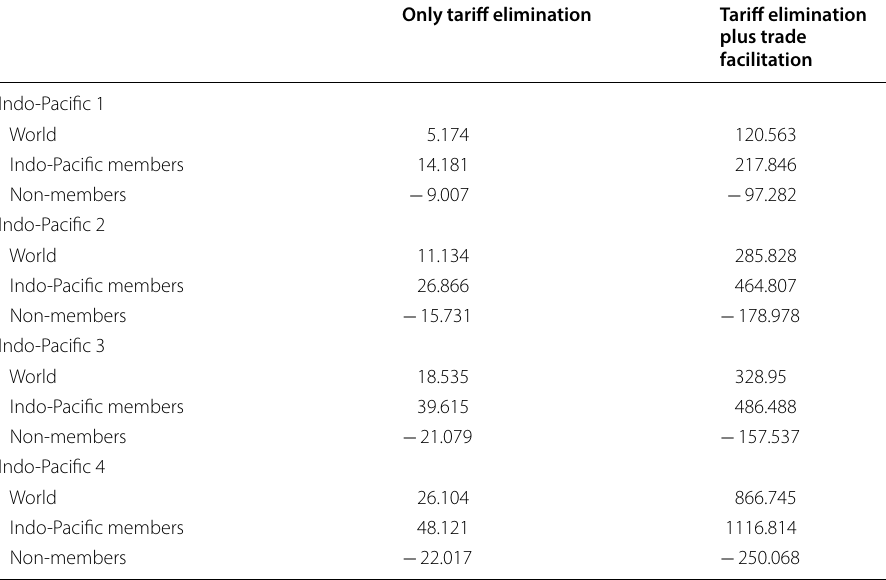
Table 12 A comparative welfare analysis (US$ billion). Source: Authors’ simulation